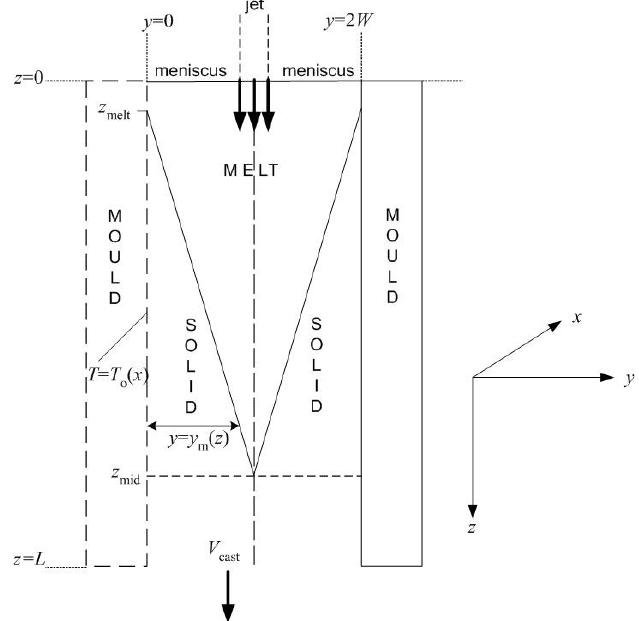
Figure 2. Schematic of a vertical continuous casting